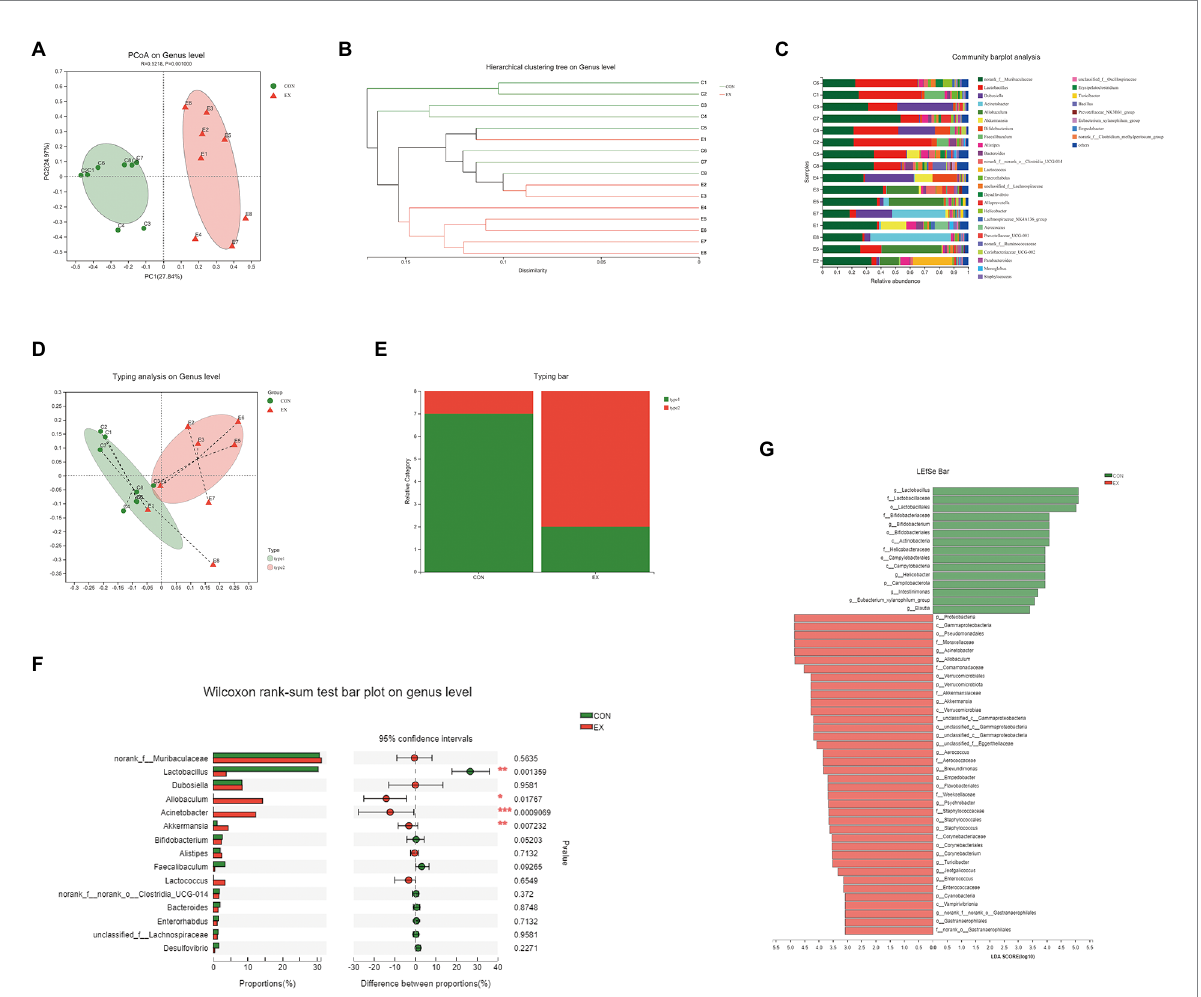
FIGURE 3 High-intensity aerobic exercise remodeled the gut microbiota structure (CON vs. EX). (A) A clear separation was observed by principal coordinate analysis (PCoA) based on the hellinger. (B) Hierarchical cluster analysis based on unweighted_unifrac. (C) Species composition of 16 samples on the genus level. (D,E) 16 samples were clustered into 2 distinct enterotypes using abund_jaccard. (F) The Wilcoxon rank-sum test bar plot on the genus level. (G) Results of the LEfSe